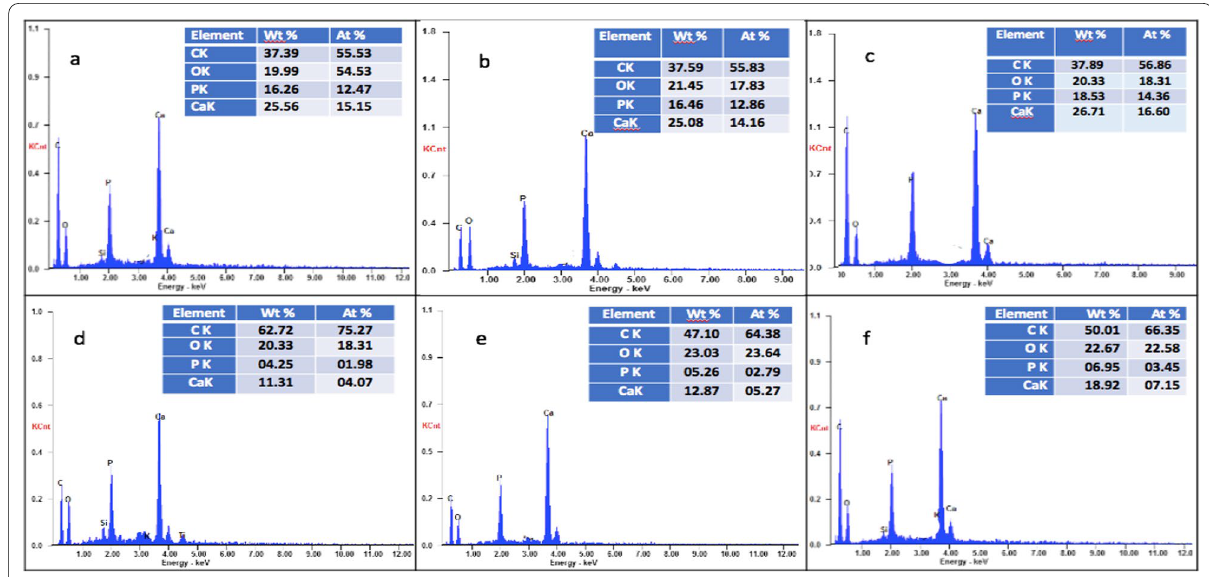
Fig. 9 Representative figures for the elemental analysis by EDX ( a ). Sound dentin restored with CGIC; ( b ). Sound dentin restored with 5% C3A‑GIC; ( c ). Sound dentin restored with 10% C3A‑GIC; ( d ) CAD restored with CGIC; ( e ). CAD restored with 5% C3A‑GIC; ( f ). CAD restored with 10%